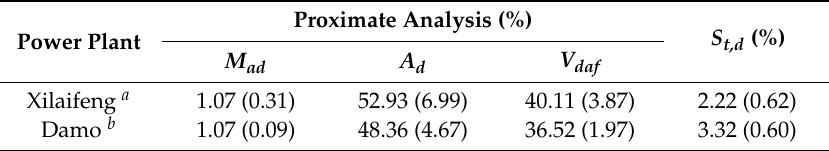
Table 1. Average values of proximate analysis (%) and total sulfur (%) of feed coals from the Xilaifeng and Damo power plants. Power Plant